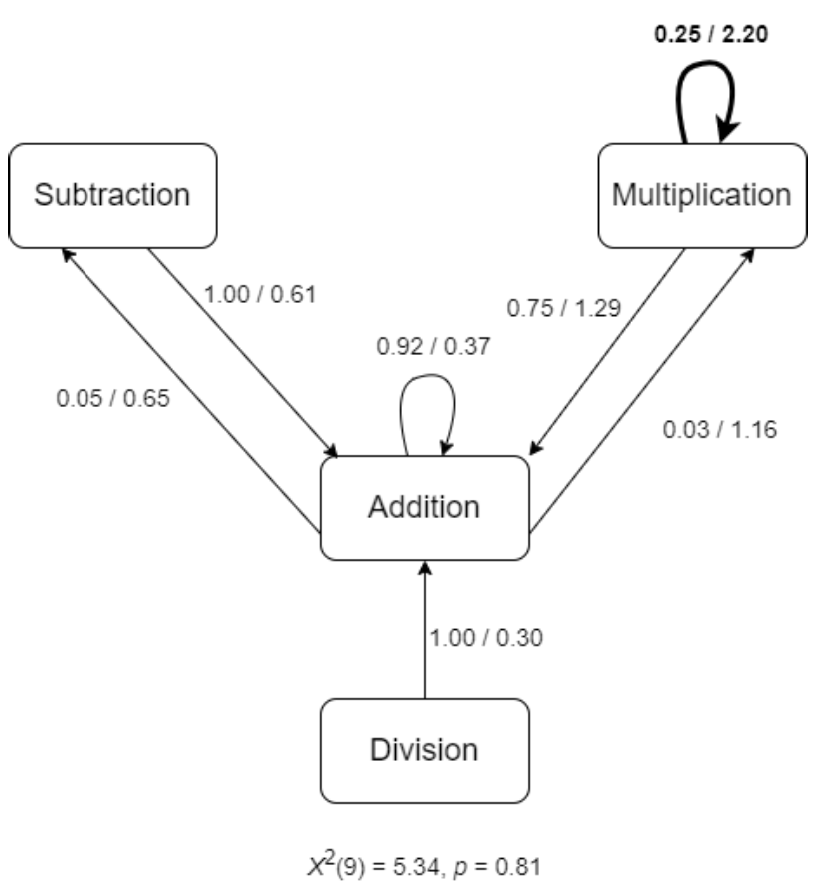
Figure 6. The sequential problem-solving behavior of hare hunters in terms of types of problem solved revealed that they were solving all types of arithmetic problems.